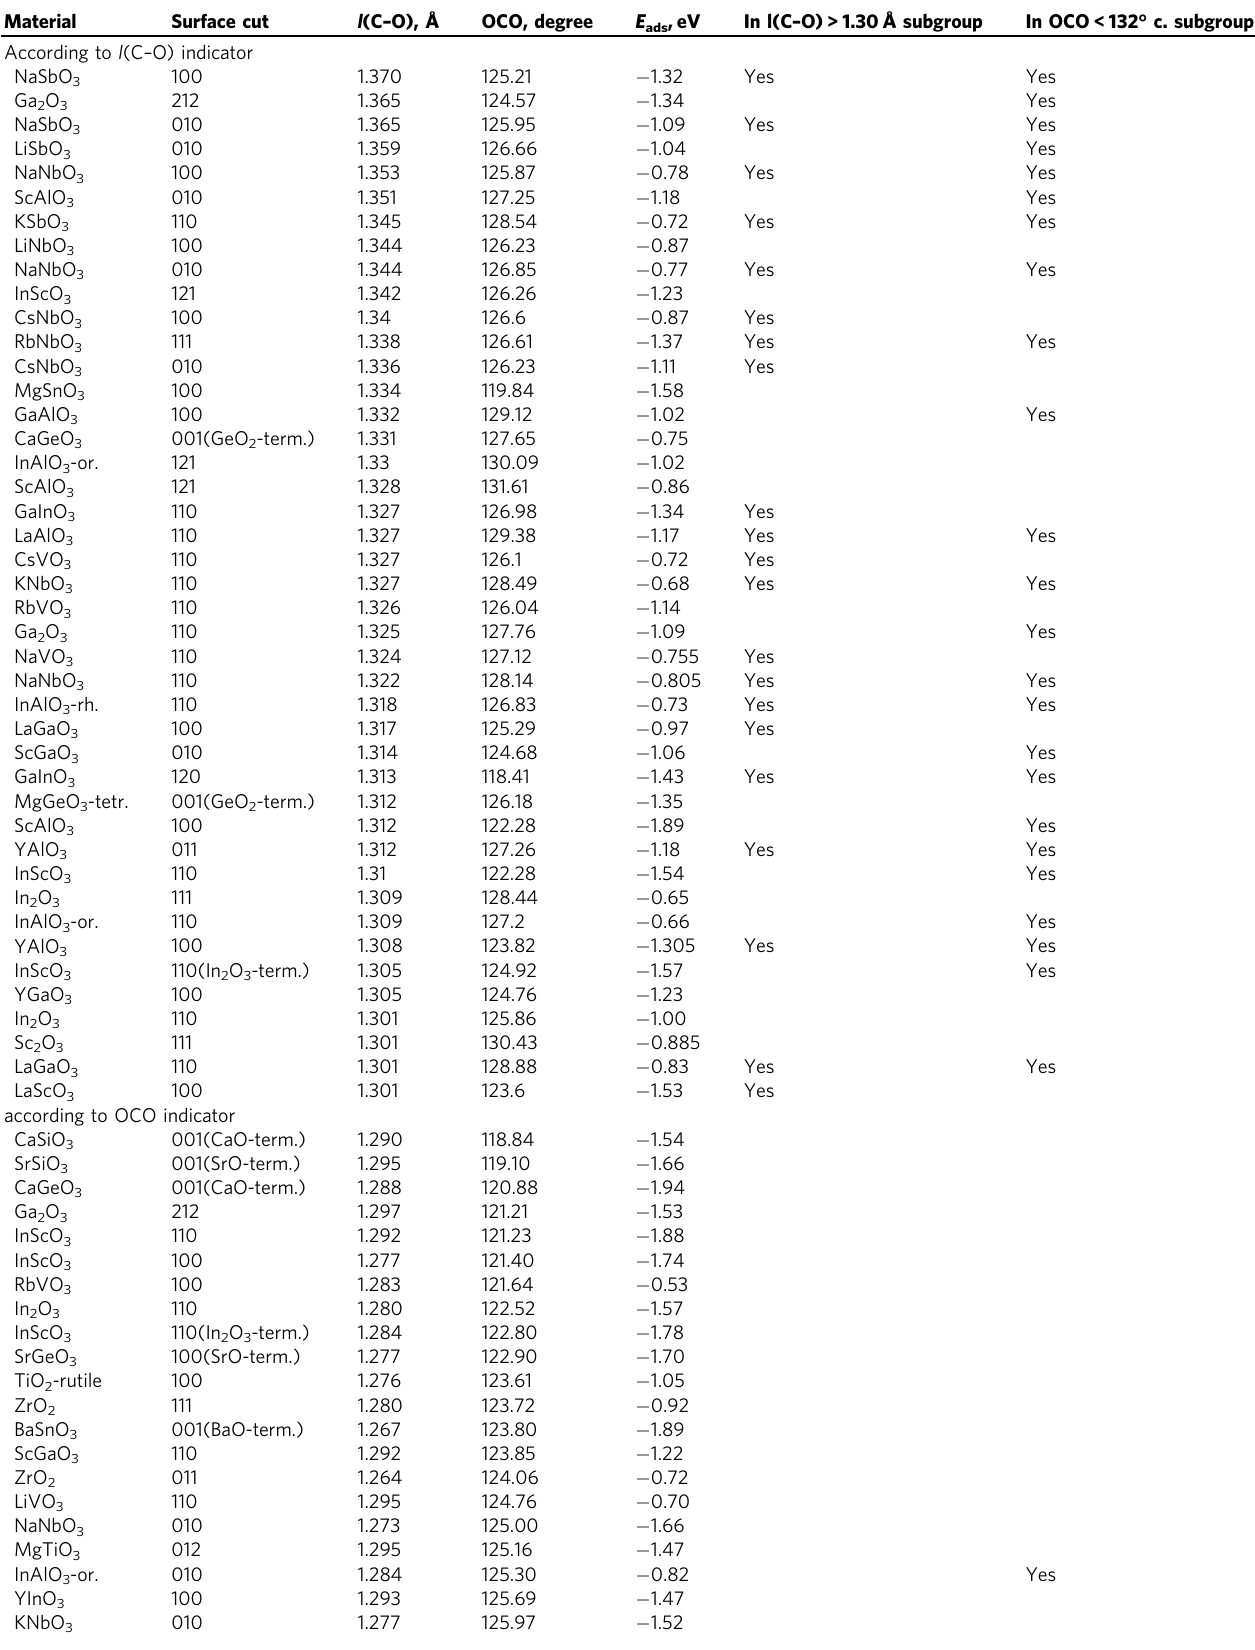
Table 4 Best materials and surface cuts for CO 2 activation according to the l (C – O) and OCO indicators.